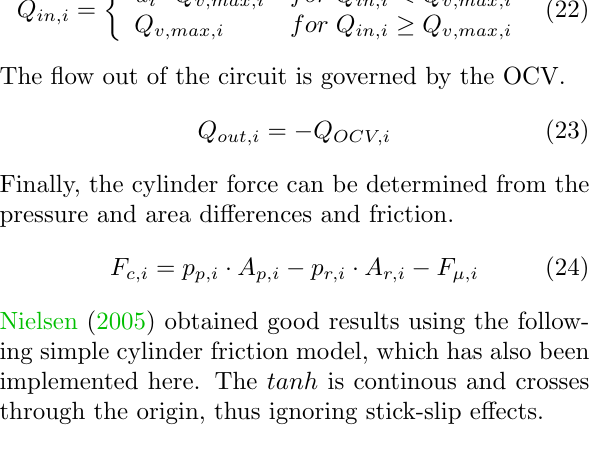
Figure 7: Fitted location of COM and moments of in- ertia for the extension system.